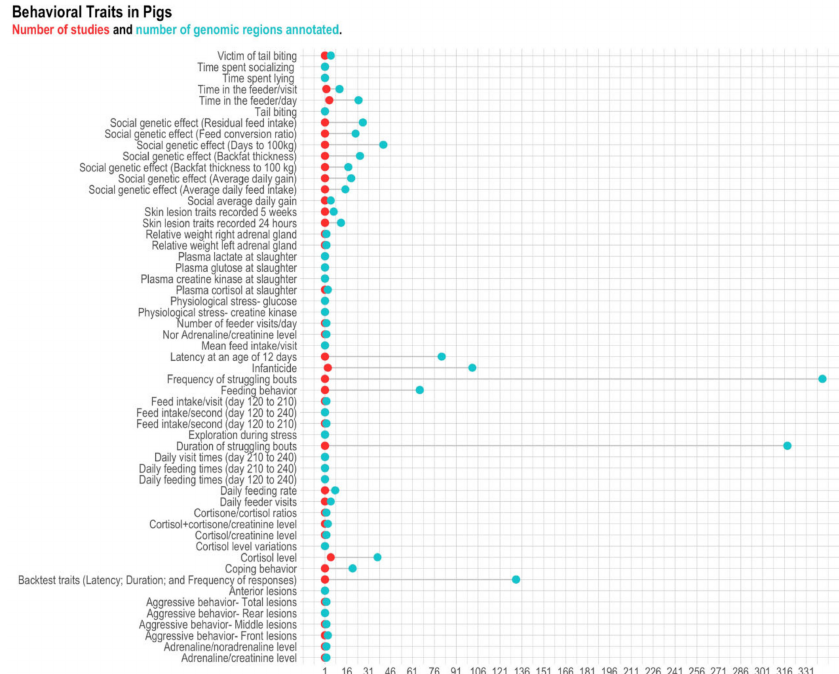
Figure 4. Number of genomic regions and reference per behavior-related trait in pigs. The red dots represent the number of references (studies), and blue dots represent the number of genomic regions. Traits with a single-colored dot (e.g., time spent socializing) mean that the number of studies is equal to the number of genomic regions (therefore, the dots overlapped) .